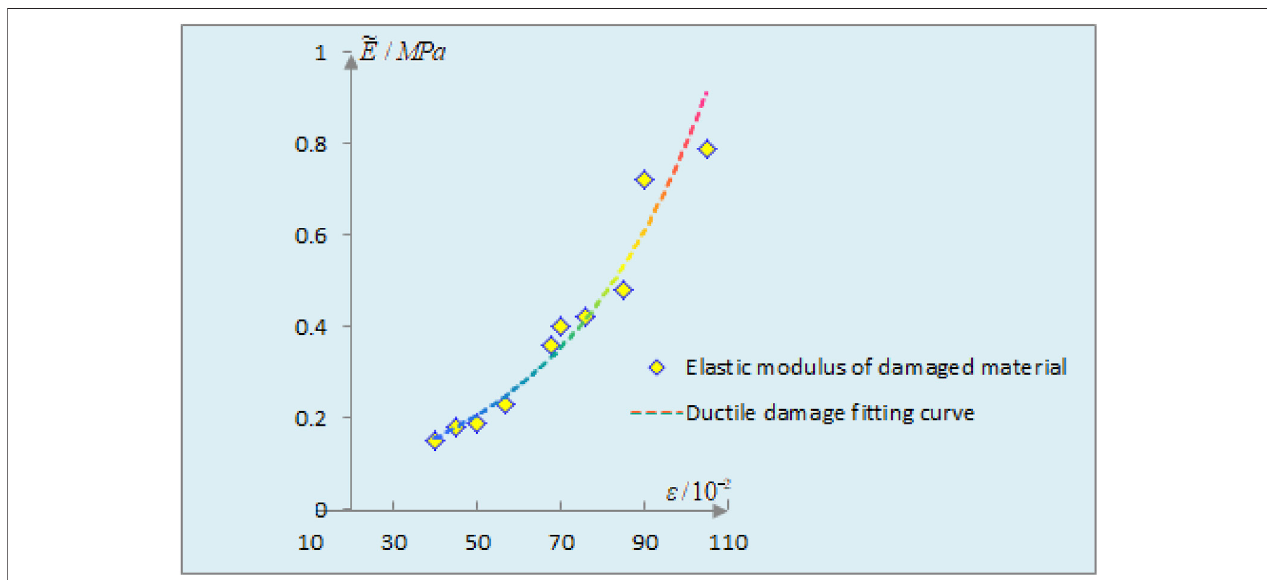
FIGURE 2 | Change in the elastic model of coarse sandstone after